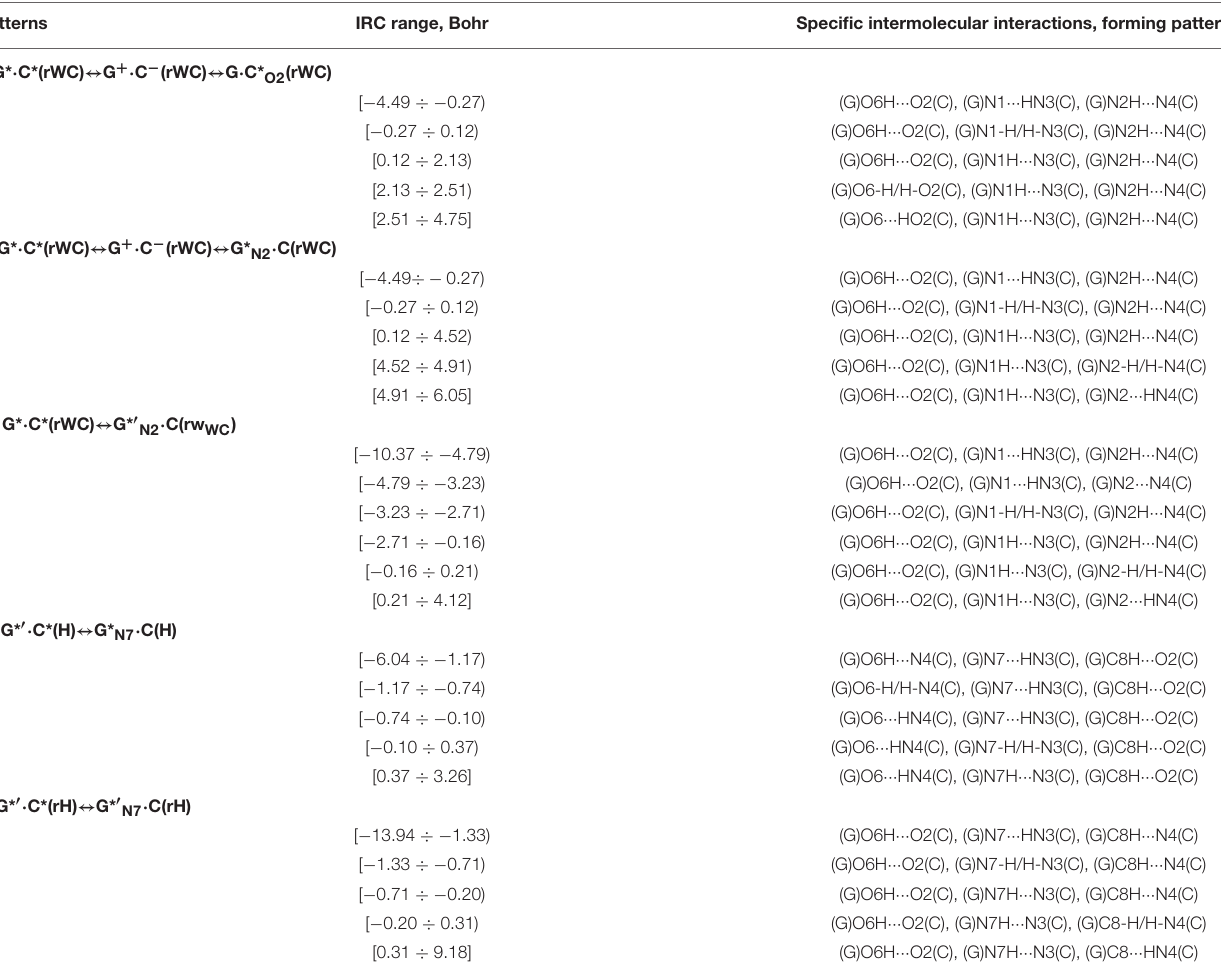
B H-bonds and loosened A-H-B covalent bridges that sequentially replace each other along ··· G(d,p) level of theory (see Figure 12 ++